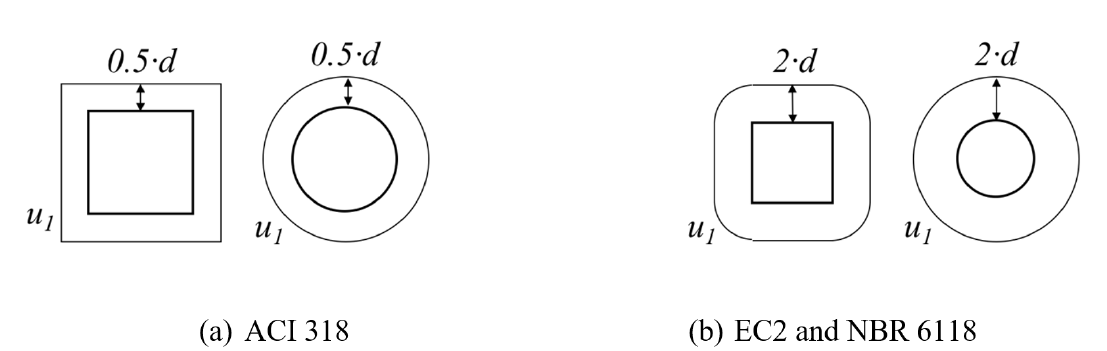
Figure 5. Control perimeters according to ACI 318, EC2 and NBR